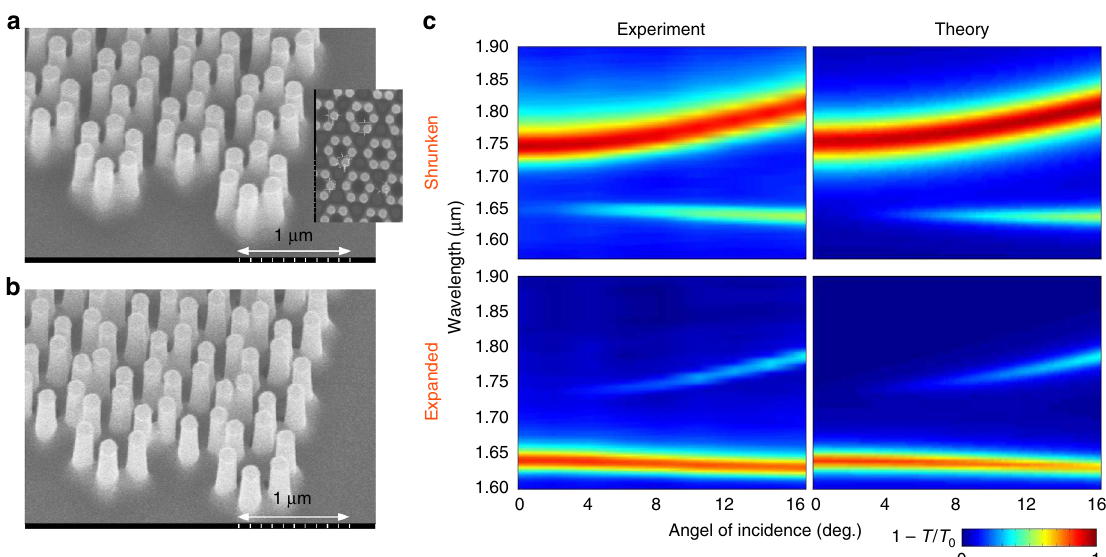
Fig. 2 Measured extinction spectra for the fabricated dielectric metasurface. a Scanning electron microscopy image of the fabricated shrunken and expanded structures with a / R = 3.15 ( a ) and a / R = 2.85 ( b ), respectively, lattice period a = 750nm, pillar height h = 1000 nm, and pillar radius r = 75 nm. c Experimental vs numerical spectra for the fabricated shrunken and expanded samples with a / R = 3.15 and a / R = 2.85, respectively. Color encodes the magnitude of ~ R ¼ 1 (cid:2) T = T 0 for p -polarized incident light